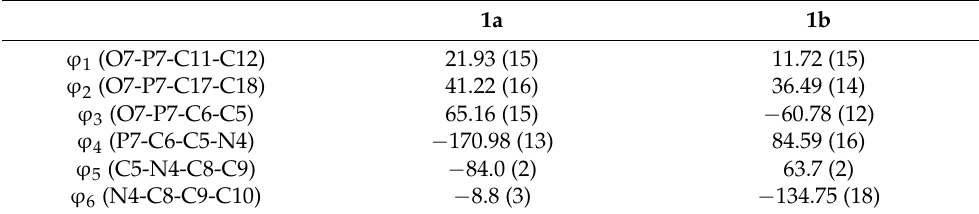
Table 2. Selected torsion angles ( ◦ ) in conformers of 1